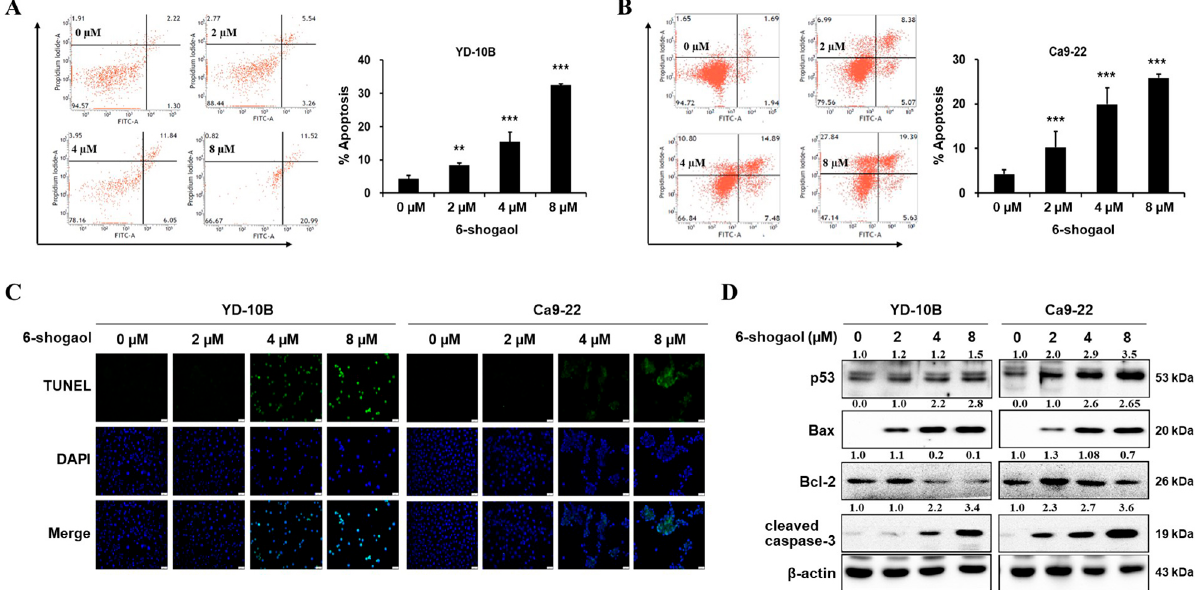
Figure 3- Effects of 6-shogaol on the apoptosis of OSCC cells. (A and B) Annexin V staining and quantification of apoptosis rates in YD- 10B and Ca9-22 cells by 6-shogaol treatment. Data are expressed as the mean ± SEM. * p<0.05, ** p<0.01, and *** p<0.001 vs control (0 µM 6-shogaol). (C) The apoptosis phenomenon of YD-10B and Ca9-22 cells treated with 6-shogaol using the TUNEL assay. (D) The expression of cell apoptosis markers, including p53, Bax, Bcl-2, and cleaved caspase-3 in 6-shogaol-treated OSCC cells by western